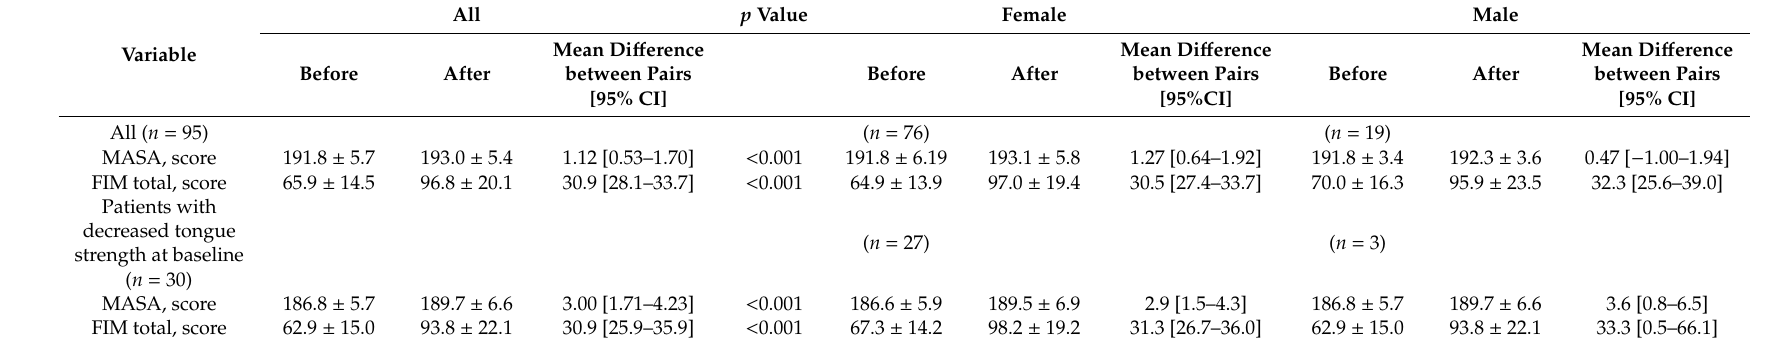
Table 3. Swallowing and physical outcomes before and after the